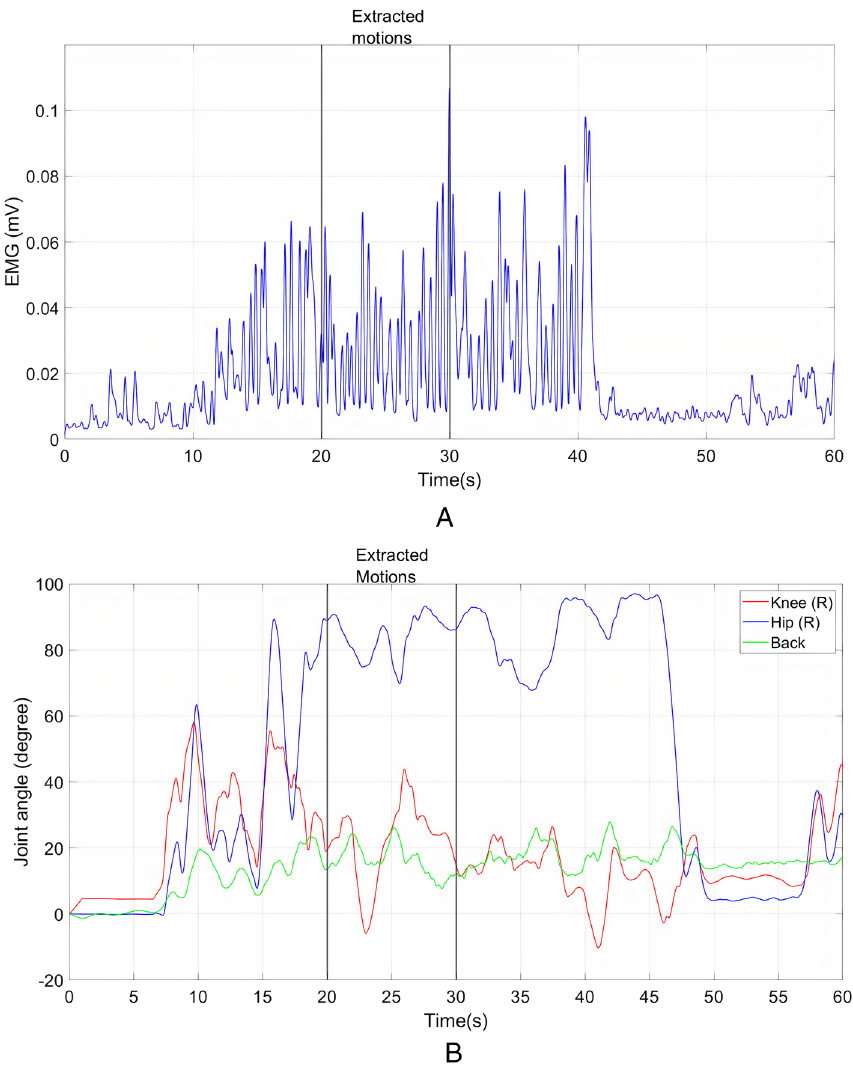
Figure 7. ( a ) EMG of right longissimus muscle ( b ) Right knee, right hip and back flexion–extension during LF